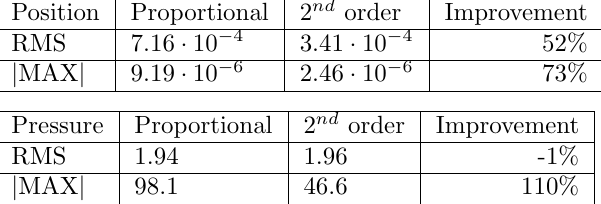
Table 2: Comparison of RMS and MAX values against experiments for a step response using a pro- portional and a second order valve dynamics model. Top: Position, Bottom: